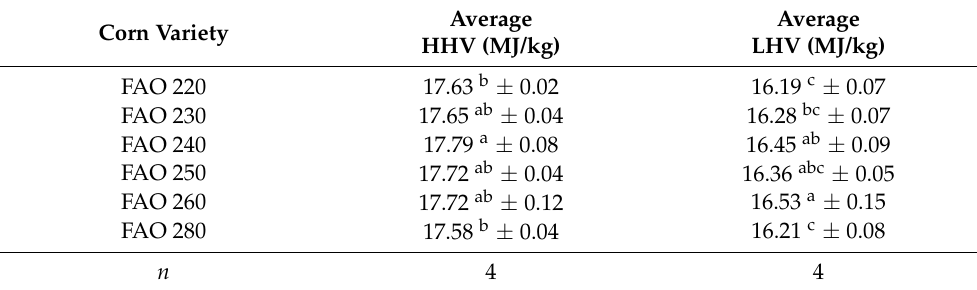
Table 7. Combustion heat and calorific value of seasoned corn cob cores. Corn